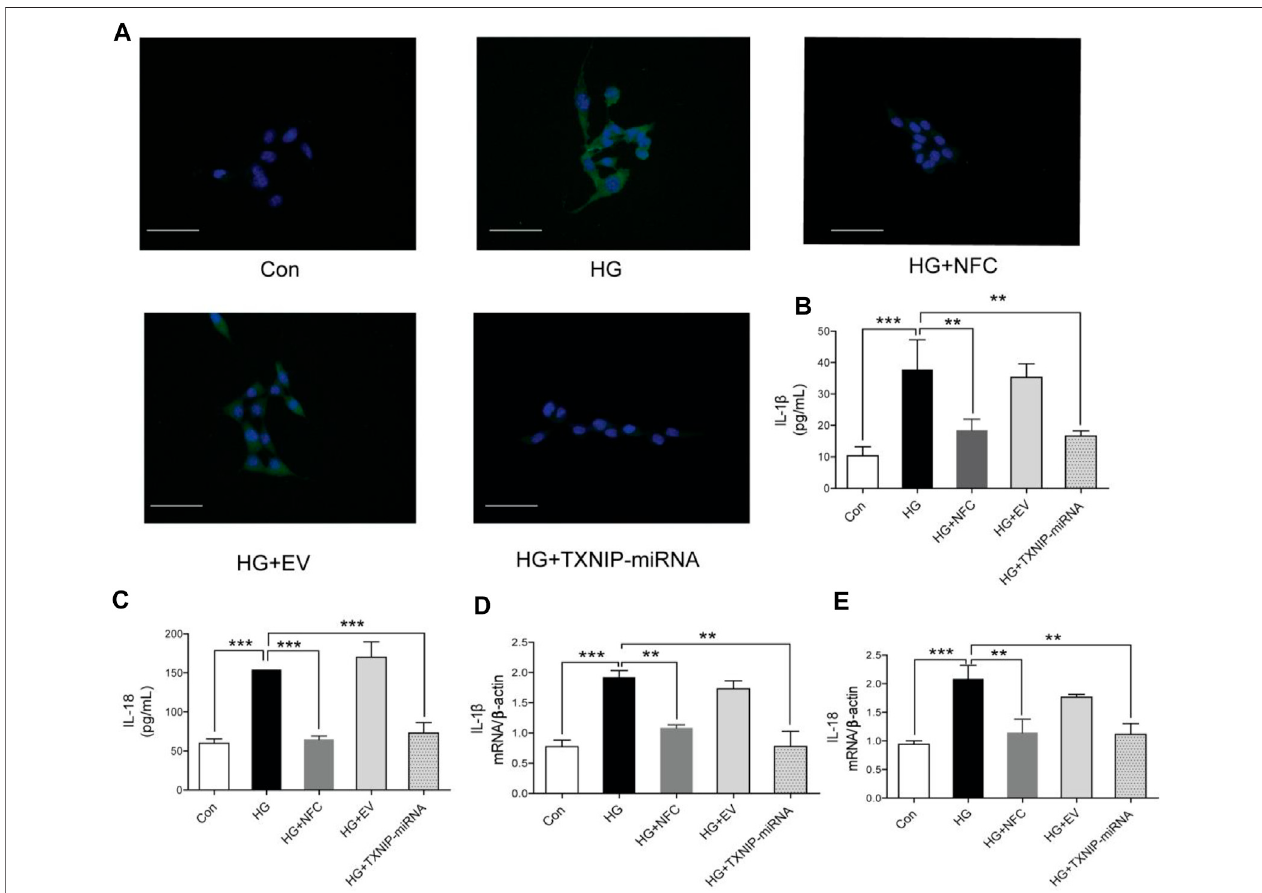
FIGURE 2 | Naofucong decreased apoptosis, IL-1 β and IL-18 levels in high glucose-induced HT22 hippocampal neuron cells. (A) Morphological photomicrographs of TUNEL staining. TUNEL positive staining cells were labeled as green, scale bar (cid:2) 30 μ m. (B, C) Effects of NFC on IL-1 β and IL-18 levels of HT22 cellsinhighglucose. (D,E) EffectsofNFConIL-1 β andIL-18mRNAlevelsofHT22cellsinhighglucose.Valuesaremeans ± SEM, n (cid:2) 5pergroup,* p < 0.05, ** p < 0.01, *** p < 0.001. Naofucong suppressed NLRP1/caspase-1 mediated neuronal injury in high glucose-induced HT22 hippocampal neuron cells.